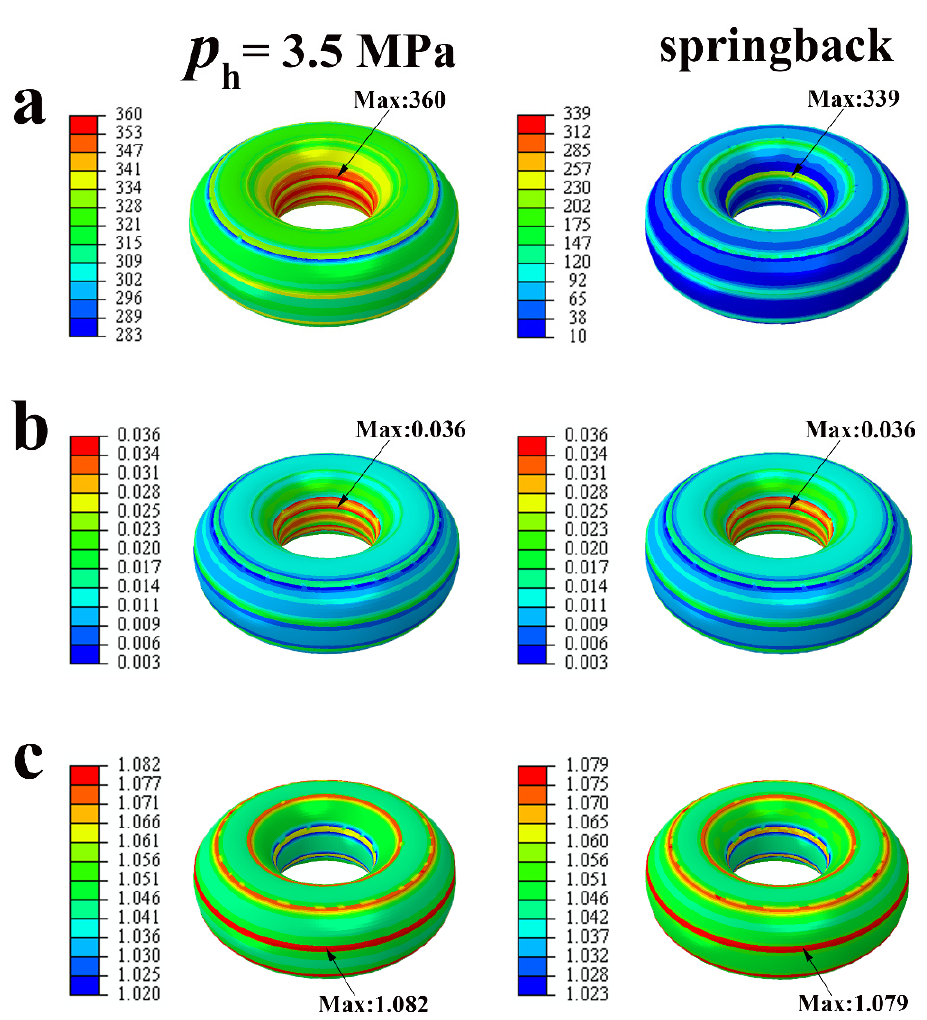
Figure 8. Contour plots of equivalent stress ( a ), plastic strain ( b ), and wall thickness ( c ) for the nominal geometry.